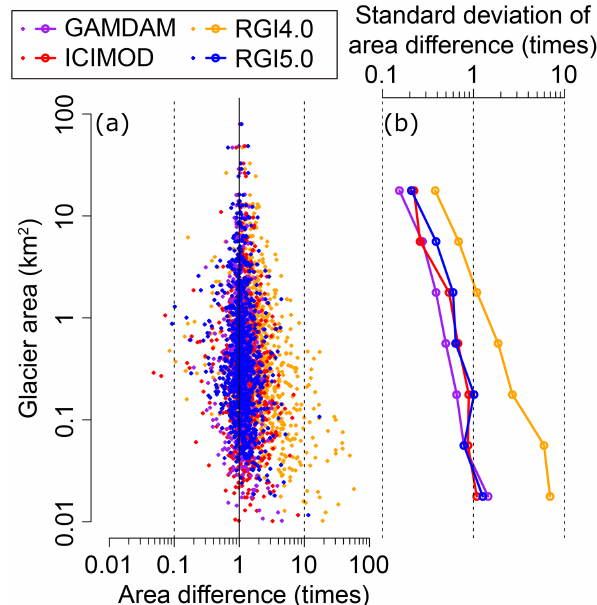
Figure 16. (a) Area difference between the ALOS-derived glacier inventory and other inventories. (b) Standard deviations of area dif- ference are summarised in seven area